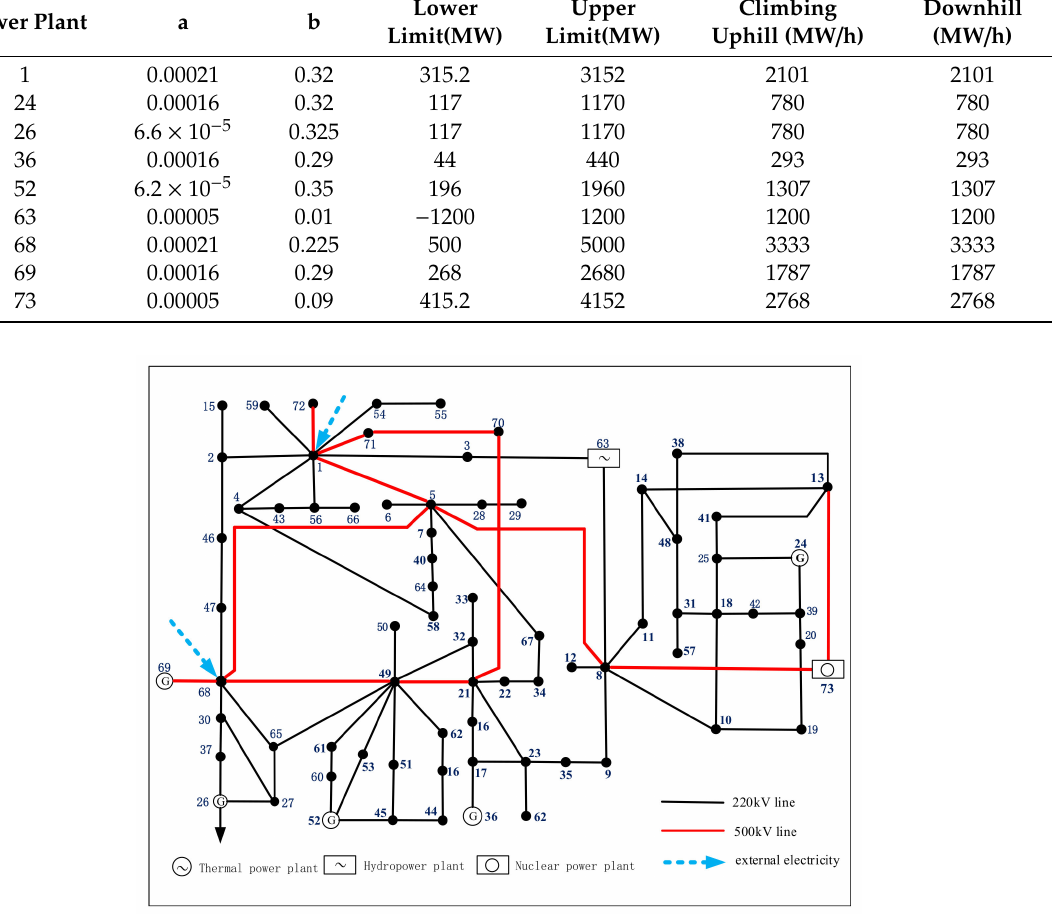
Figure 7. Grid connection diagram for a regional power grid.